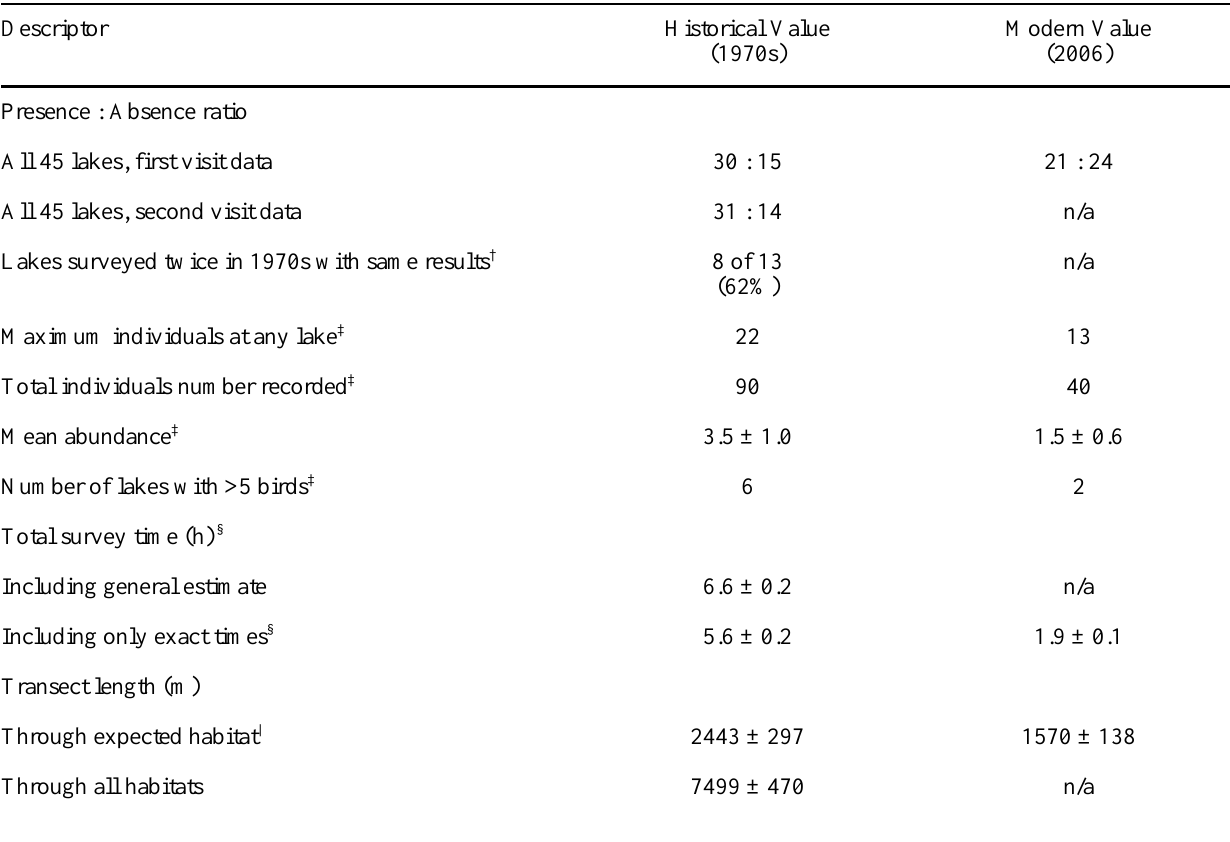
Table 1. Comparison of historical and modern data for Rusty Blackbirds at 45 lakes visited in the 1970s and in 2006 in the Mackenzie Valley, NT, Canada. Thirteen lakes were visited twice in the 1970s, so two presence absence ratios are presented for the historical data. SE is presented for